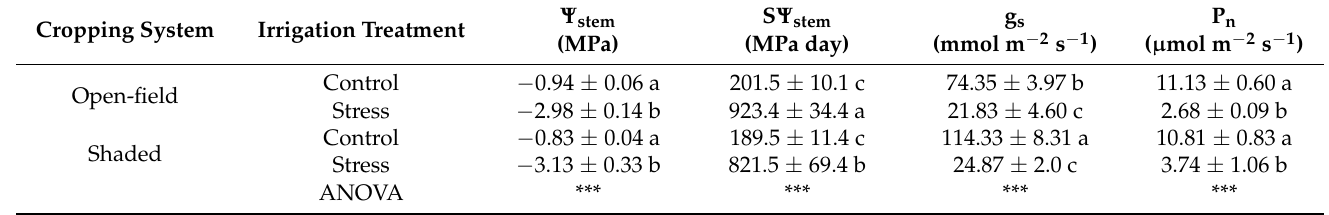
Table 2. Stem water potential ( Ψ stem ), accumulated water stress integral (S Ψ stem ), stomatal conduc- tance (g s ) and net photosynthesis (P n ) values at the end of the stress period (DOY, day of the year, 267) in control and stress lime trees grown in open-field and shaded